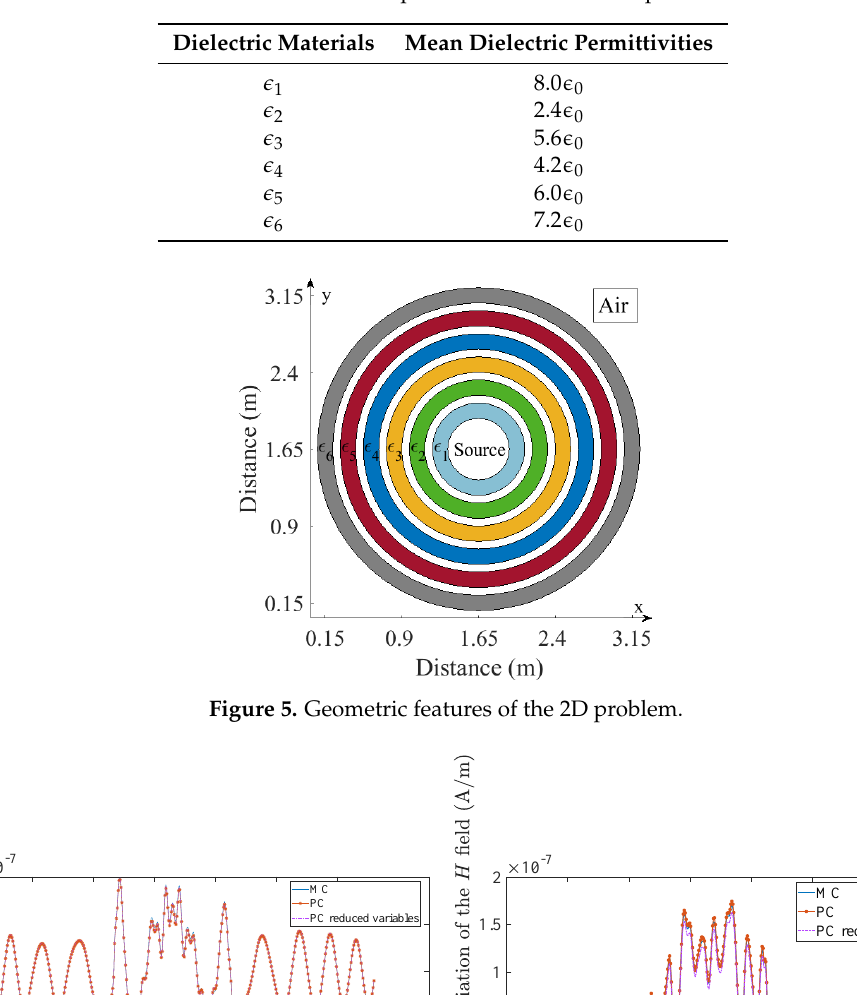
Table 2. Mean dielectric permittivities for the 2D problem.